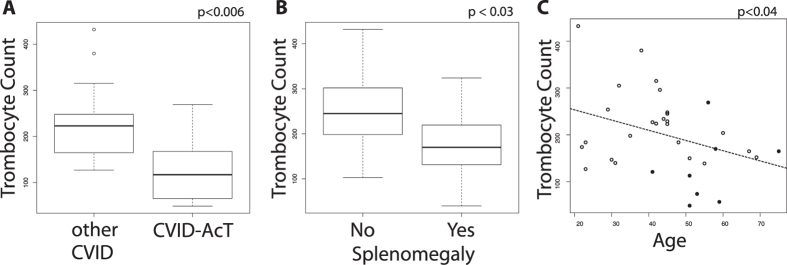
Trombocyte counts are significantly reduced in CVID-AcT patients, patients with splenomegaly and decrease with age.The thrombocyte count is significantly lower in CVID-AcT patients compared to other CVID patients (A), as well as in patients with splenomegaly (B) and it decreases with age (C).